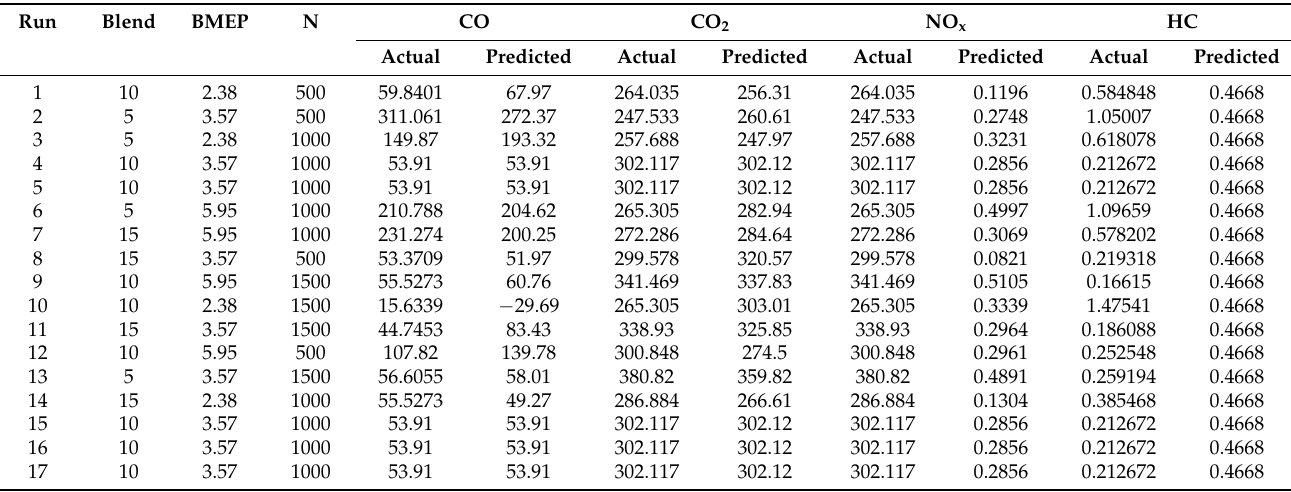
Table 6. Details of actual vs. predicted responses of output parameters